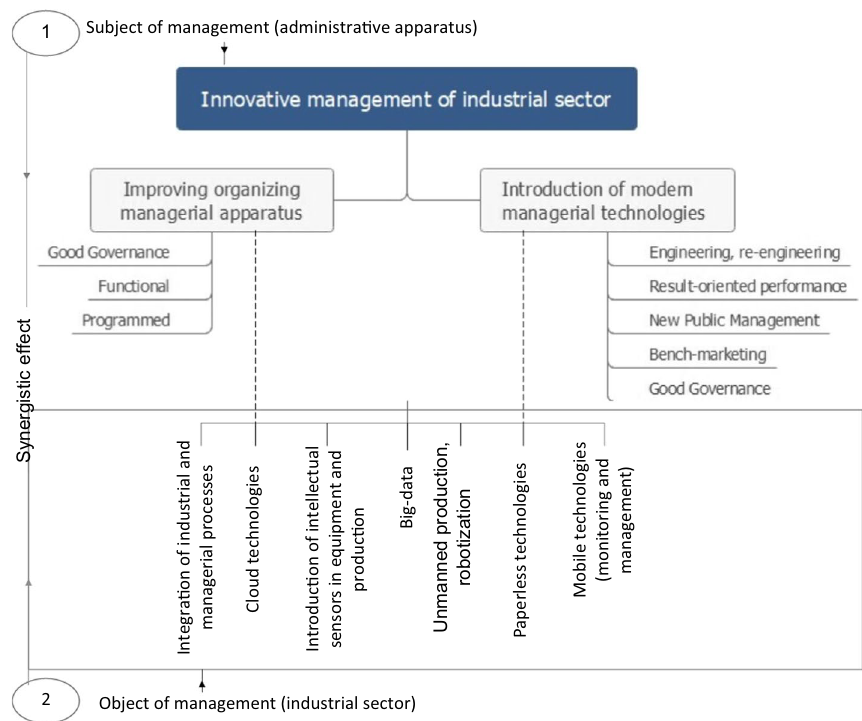
Fig. 1 Innovative management of industrial sector. Source: developed by the authors based on Sherimova (2019), Bowden et al. (2020), Bueno et al.